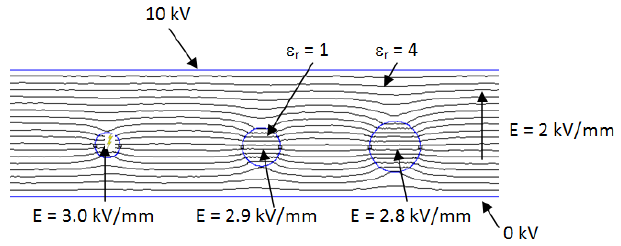
Figure 24. A model of an insulation layer containing three voids. Even if the electrical field in the insulation material is under 2 kV/mm, the electrical field in one void is over 3.0 kV/mm and electrical discharge may appear in such a void if it is fill with air (breakdown voltage of the air is 3.0 kV/mm).